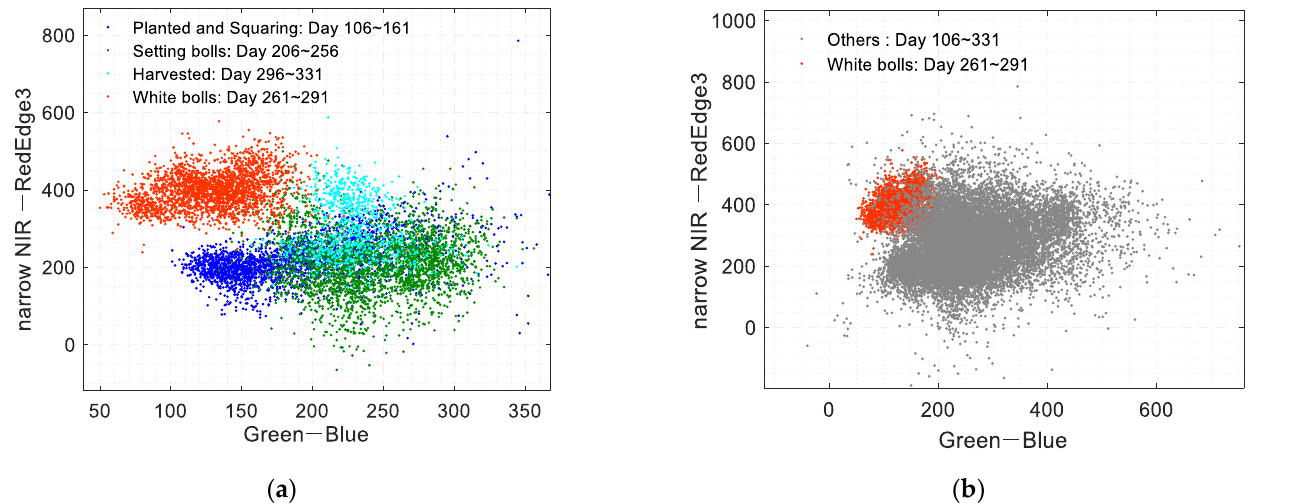
Figure 5. ( a ) The scatter plot of cotton in bolls opening stage and other phenological stages. ( b ) The scatter plot of white bolls and other crops (corn, sorghum, soybean, rice, and peanuts) from the planting stage to the harvesting stage.